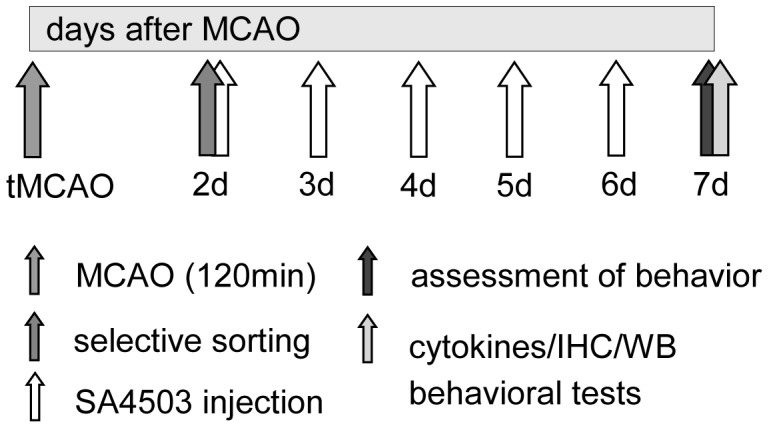
Experimental design.